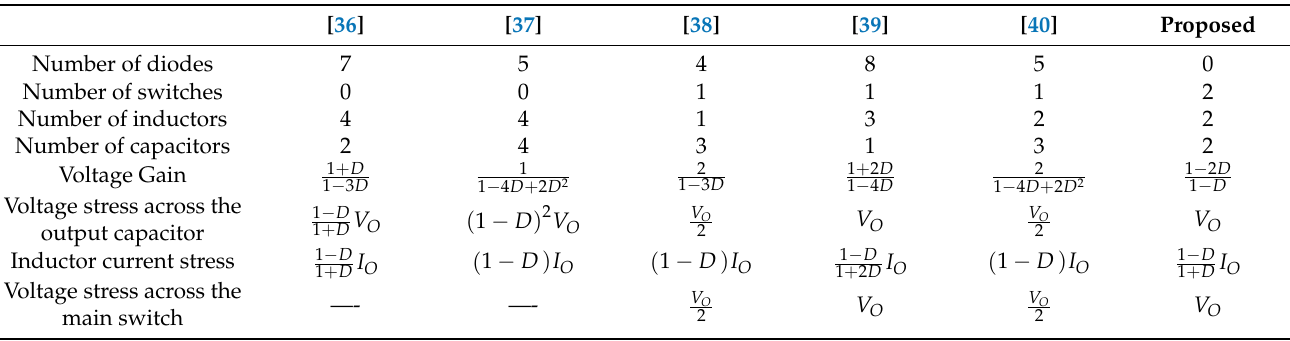
Figure 12. ( a ) Voltage gain: ( b ) voltage and ( c ) current stresses of the proposed boost converter in comparison with converters in [16 – 20] and [51,52]. Table 2. Comparison between the selected and other Z-source